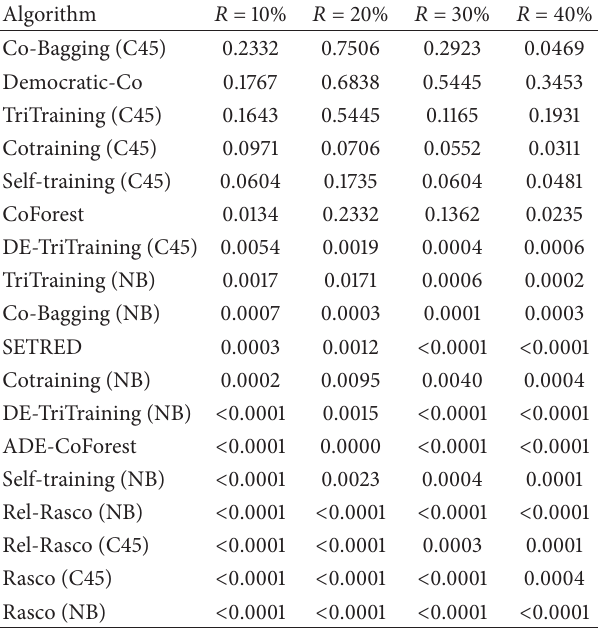
Table 6: Rankings of the algorithms in all tested labeled ratios according to Holm/Hochberg (alpha =